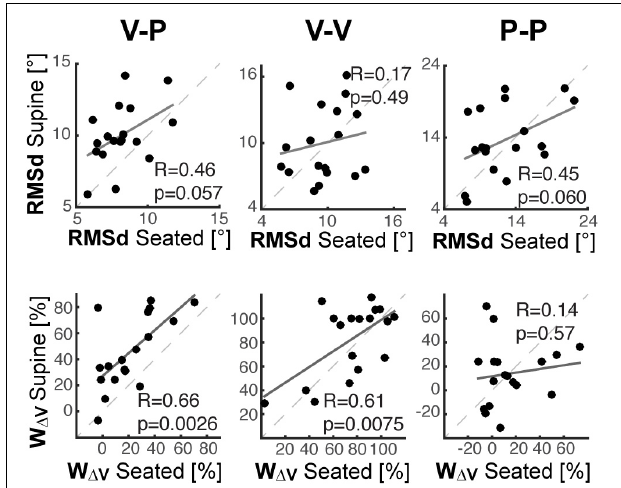
FIGURE 6 | Inter-individual analyses. For each of the three experiments cross-modal (left), unimodal visual (middle) and unimodal proprioceptive (right), individual performance in the Supine condition are shown as a function of the performance in the Seated condition, in terms of response variability (top row) and visual dependency (bottom row). Dashed lines correspond to the identity line. Solid lines correspond to the linear interpolation of the data. “R” is the coefficient of correlation between the Seated and Supine data and “p” represents the corresponding statistical